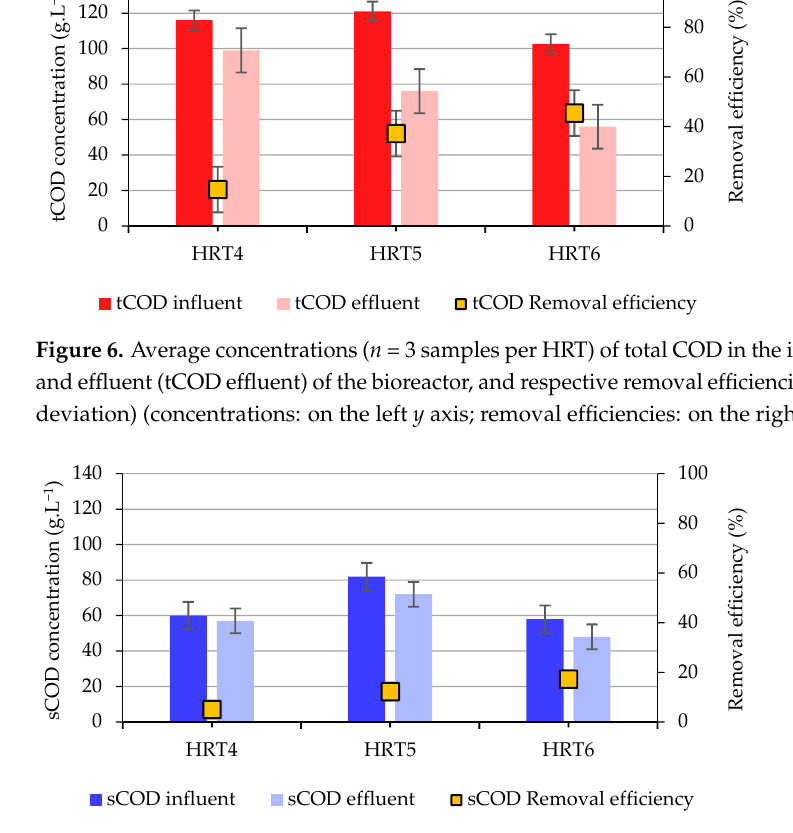
Figure 7. Average concentrations ( n = 3 samples per HRT) of soluble COD in the influent (sCOD influent) and effluent (sCOD effluent) of the bioreactor, and respective removal efficiencies (error bars: standard deviation) (concentrations: on the left y axis; removal efficiencies: on the right y axis).